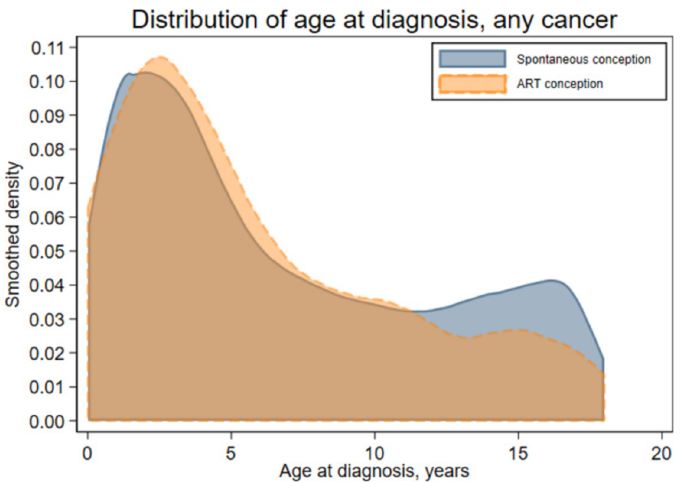
The IRs for any cancer and different cancer types by country of birth are presented in S4 Table. Sensitivity analyses, including adjustment for any smoking during pregnancy or highest